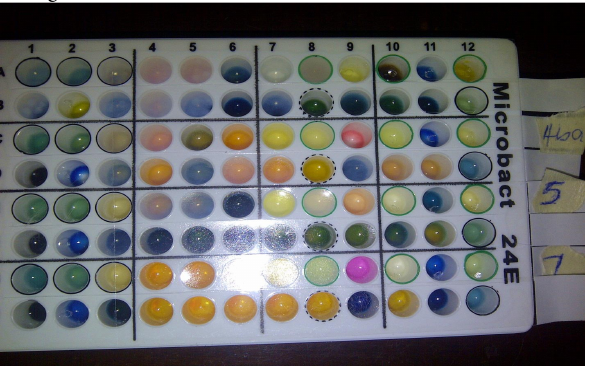
Fig. 8. Changes in the pH of varying concentrations of sodium chloride preserved powder of mango seed kernels stored at room temperature for 12 weeks. Each reading represents an average of 3 determinates